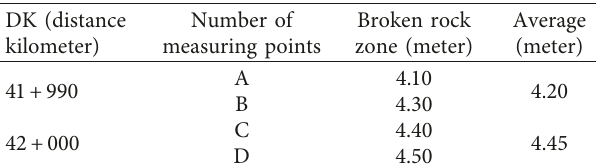
Figure 8: The relationship between the wave velocity and the depth of the drilling hole of the test point D. Table 1: The results of broken rock zone tests.